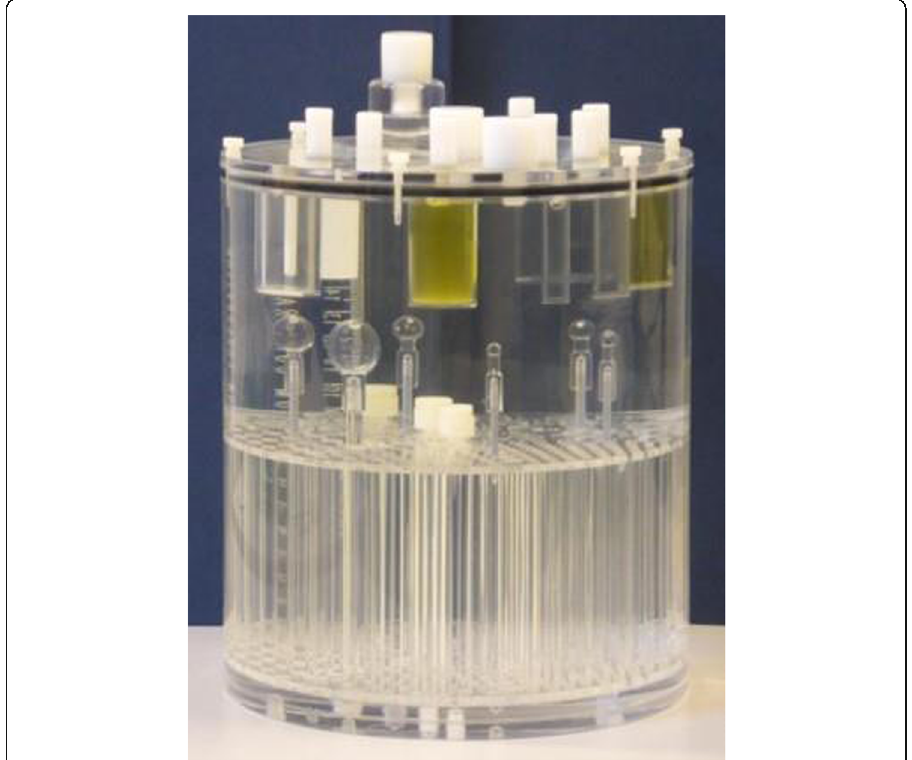
Fig. 1 Esser PET phantom with additional coplanar hot spheres of 4, 5, 6, 8, 12, and 20 mm, attached to the bottom of the